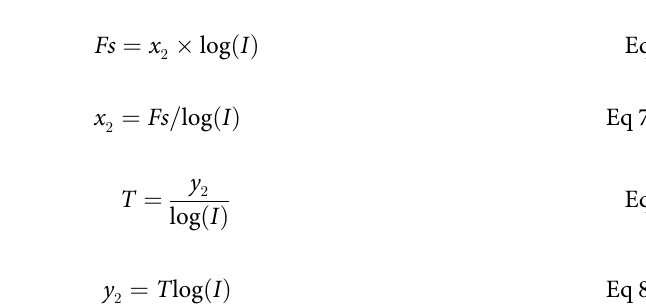
Plotting the PP, PP , and Fs/T values revealed a pattern similar as expected (Fig 9, black T data points). For the second microbe, we aimed to model disease progression based on the magnitude of the inoculum, and in doing so, used Eq 7 and 8, where x ables dependent on the mortality, Fs, T, and log(I) (Eqs 7.1 and 8.1). For the purposes of Fig 9, we used x = 0.1 and y = 10.